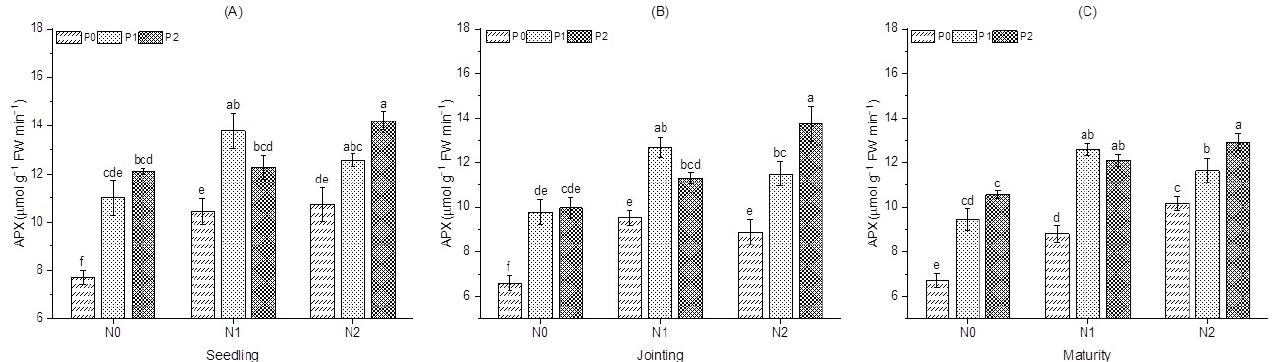
Figure 4. Effects of nitrogen and phosphorus on ascorbate peroxidase (APX) activity of sorghum plants grown in saline soils at the three growing stages of seedling, jointing, and maturity. ( A ) Seedling stage; ( B ) Jointing stage; ( C ) Maturity stage. Within each sampling date, the data followed by different letters are statistically different at the 0.05 probability level.